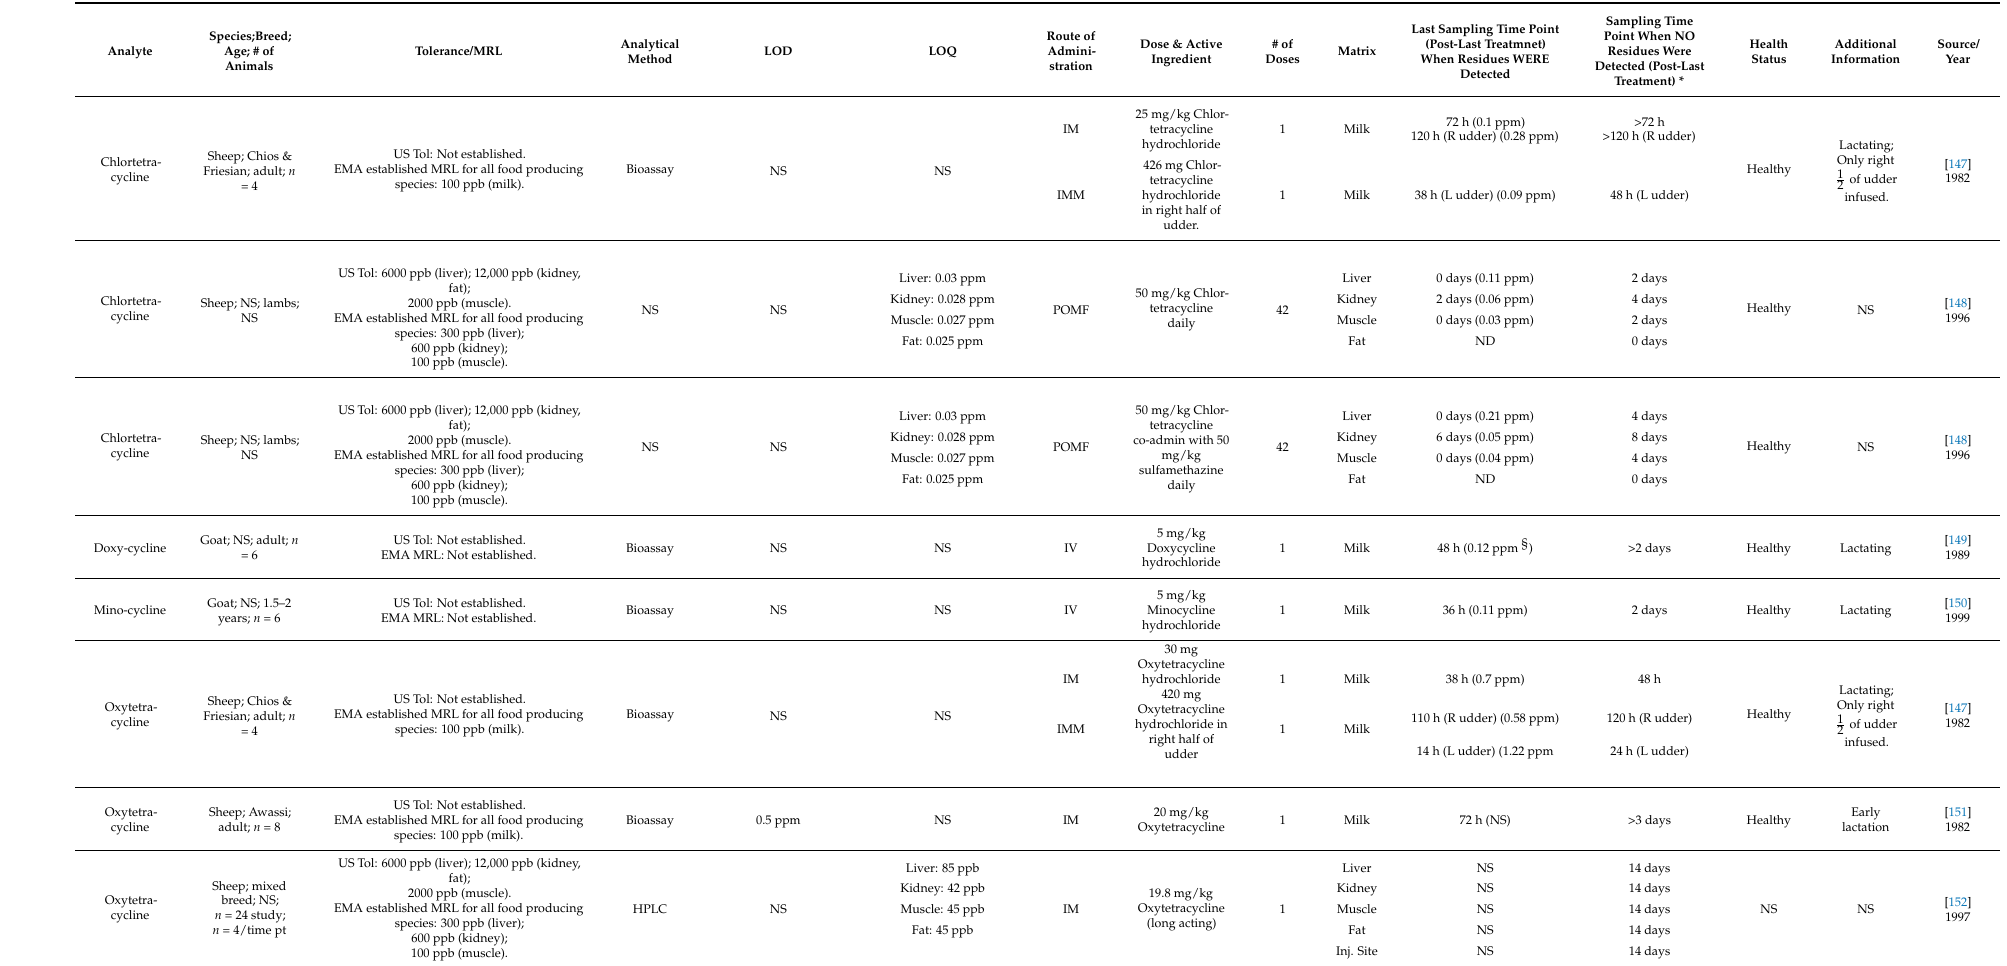
Table 8. Tetracycline residues in milk or edible tissue samples from sheep or goats following treatment.